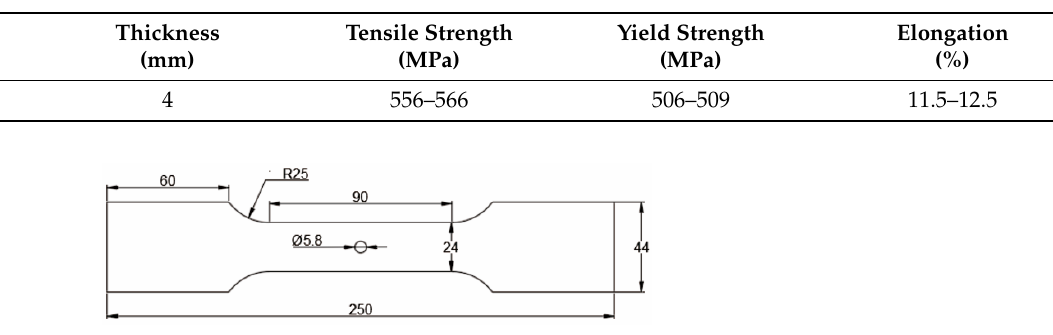
Figure 1. Single-hole aluminum alloy specimen (without cold expansion).